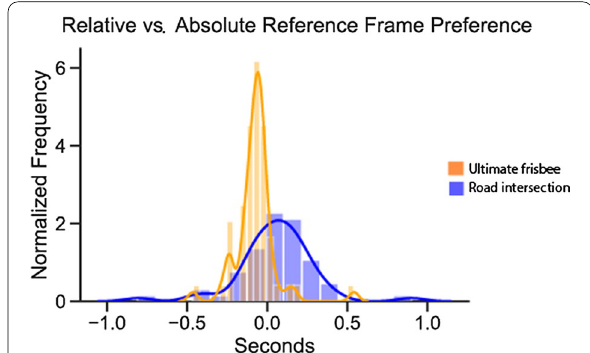
Fig. 6 Different distributions of reference frame preference for the two task contexts. A histogram of relative minus absolute reference frame preference shows a greater preference on the ultimate frisbee task for a relative reference frame compared to an absolute reference frame preference for the road intersection task. The road intersection task also shows a wider spread, suggesting that individual variability may play a more critical role in that task context compared to ultimate frisbee (at least in this sample of ultimate frisbee players)